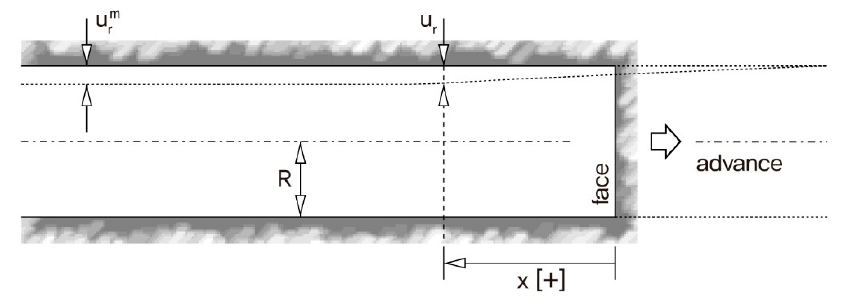
Figure 2. LDP and cross-section for tunnel excavation.